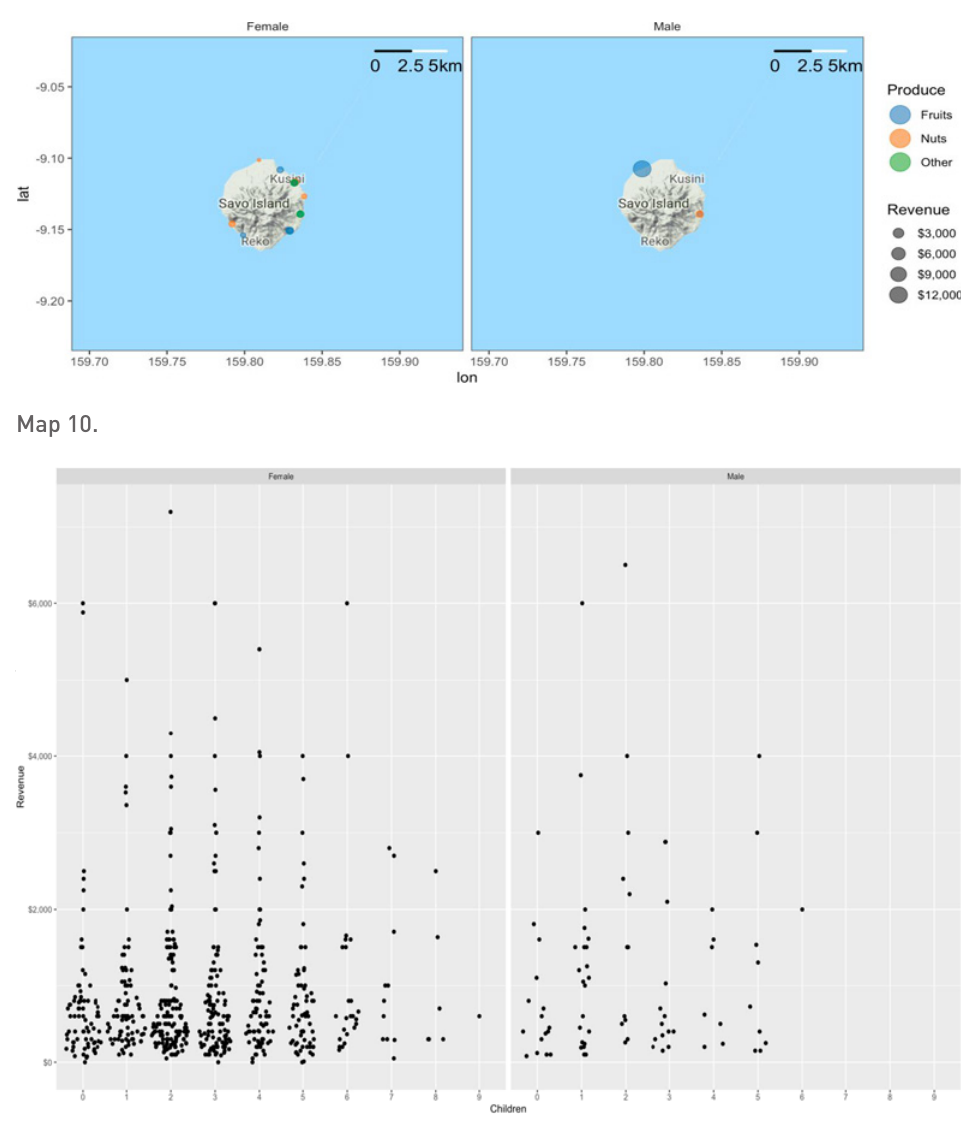
Figure 1 Producer-vendors by gender, revenue and number of children in $SI (outliers removed;